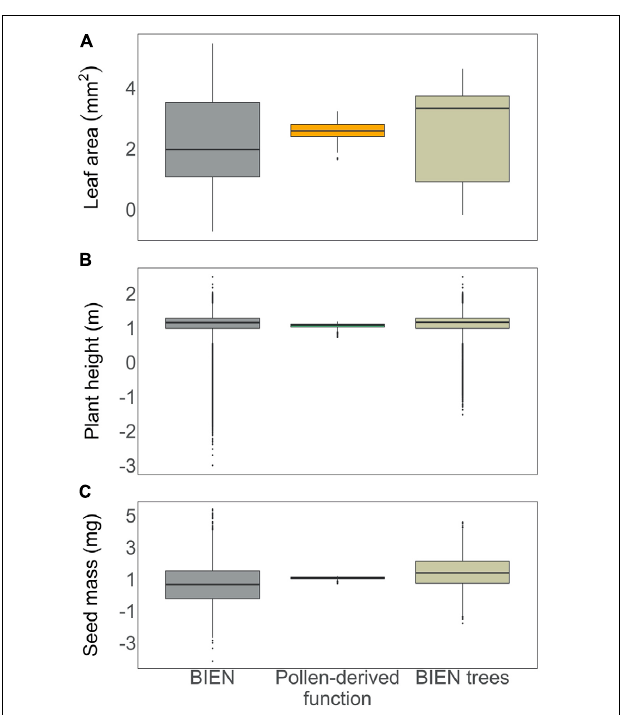
FIGURE 1 | Comparisons between the trait spaces of leaf area (A) , plant height (B) , and seed mass (C) from the list of trait measurements for species native to North America from the BIEN Database (Enquist et al., 2016), surface pollen samples (Williams et al., 2018), and native tree species (Enquist et al., 2016). Ranges of functional estimates from the pollen-plant functional trait linkage were generated using median trait values in each 0.5 ◦ × 0.5 ◦ grid cell. All traits were log-transformed. See Supplementary Table 1 for pollen-based trait